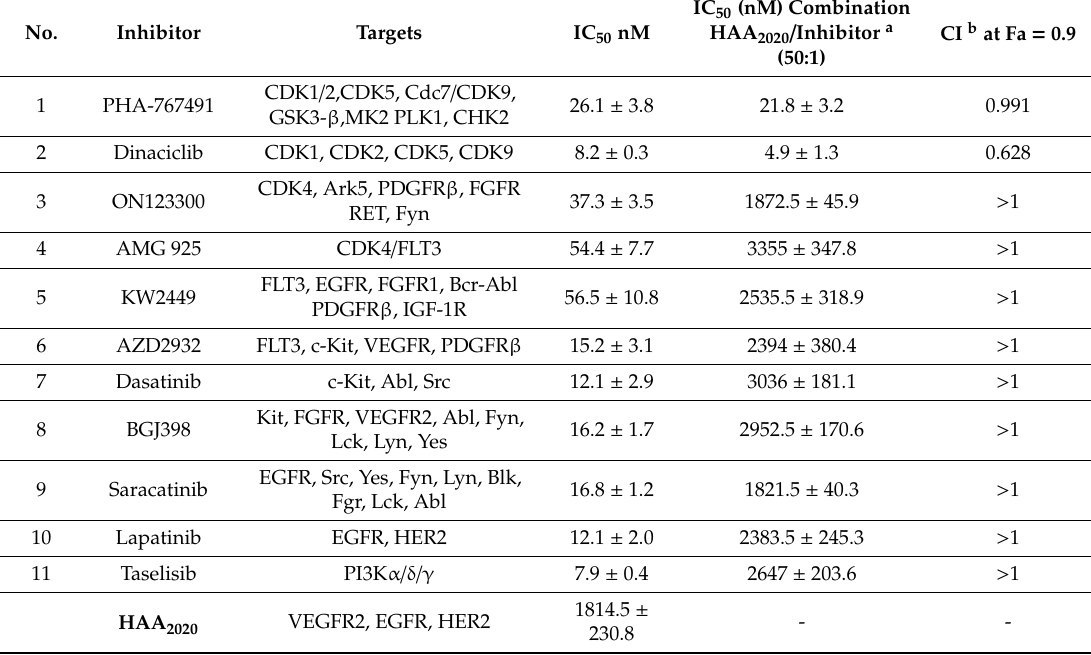
Table 2. Cytotoxic IC 50 values of HAA 2020 , the eleven inhibitors and their combinations in HL60 cells (24 h, nM).